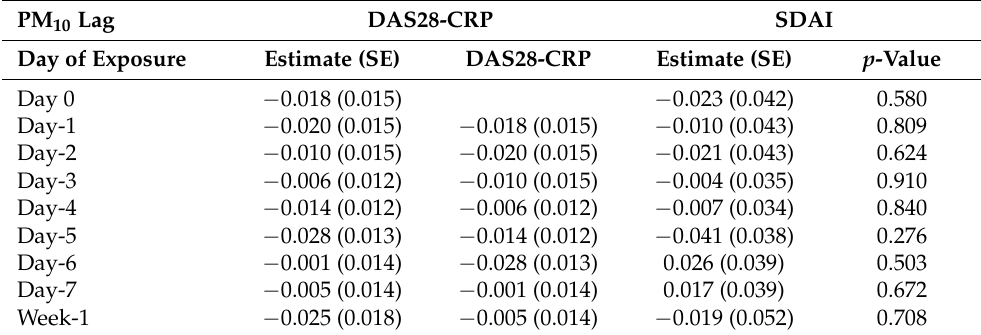
Table 3. Associations between PM 10 short-term exposure and RA disease activity.